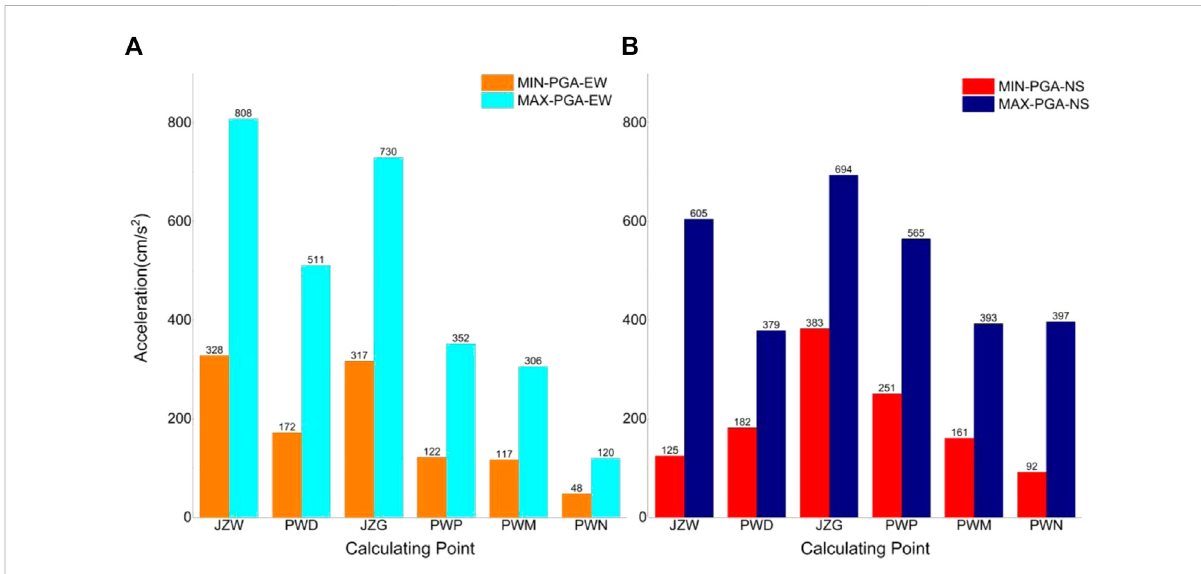
FIGURE 6 PGA value range of six typical locations. (A) Shows the PGA range of the EW component, (B) shows the PGA range of the NS